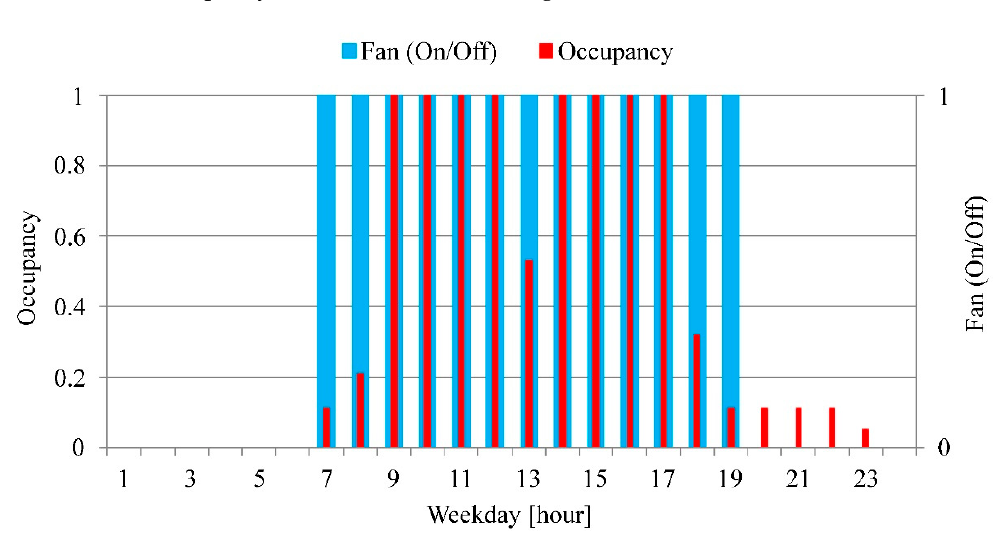
Figure 3. Fan and occupancy schedule of the case study building.